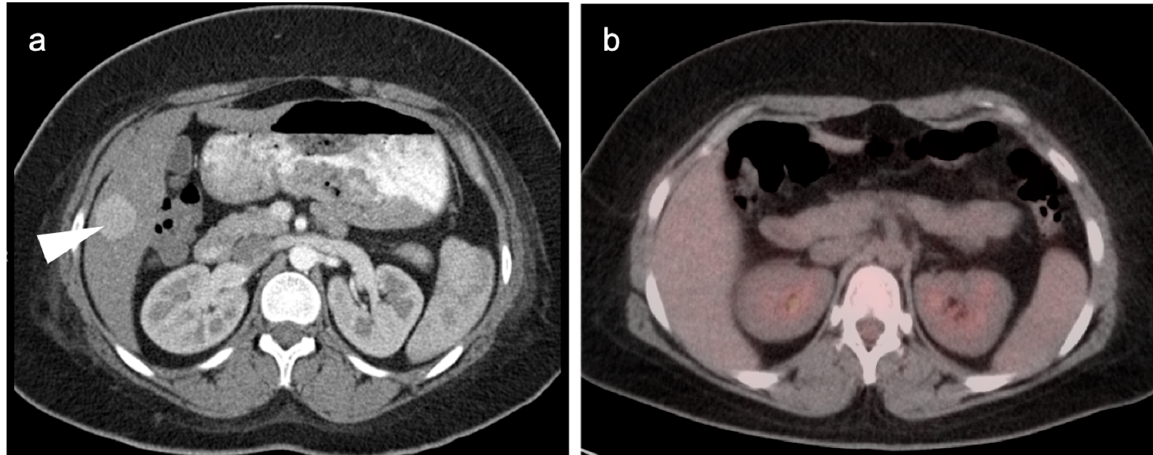
Figure 16. ( a ) A large cavernous hemangioma of the right lobe of the liver is isometabolic to the normal liver on axial fused FDG PET-CT; ( b ) On T2 axial MRI, this lesion shows typical bright signal seen in cavernous hemangiomas.